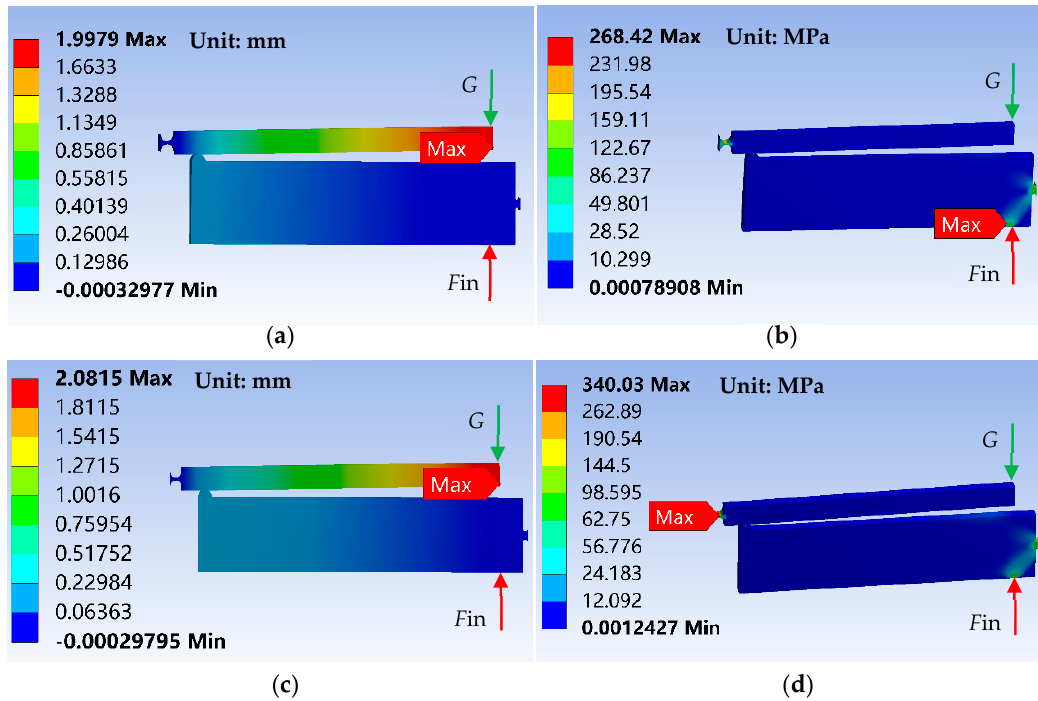
Figure 7. Deformation and Von-Mises stress levels of a two-stage flexural hinge lever-type mechanism